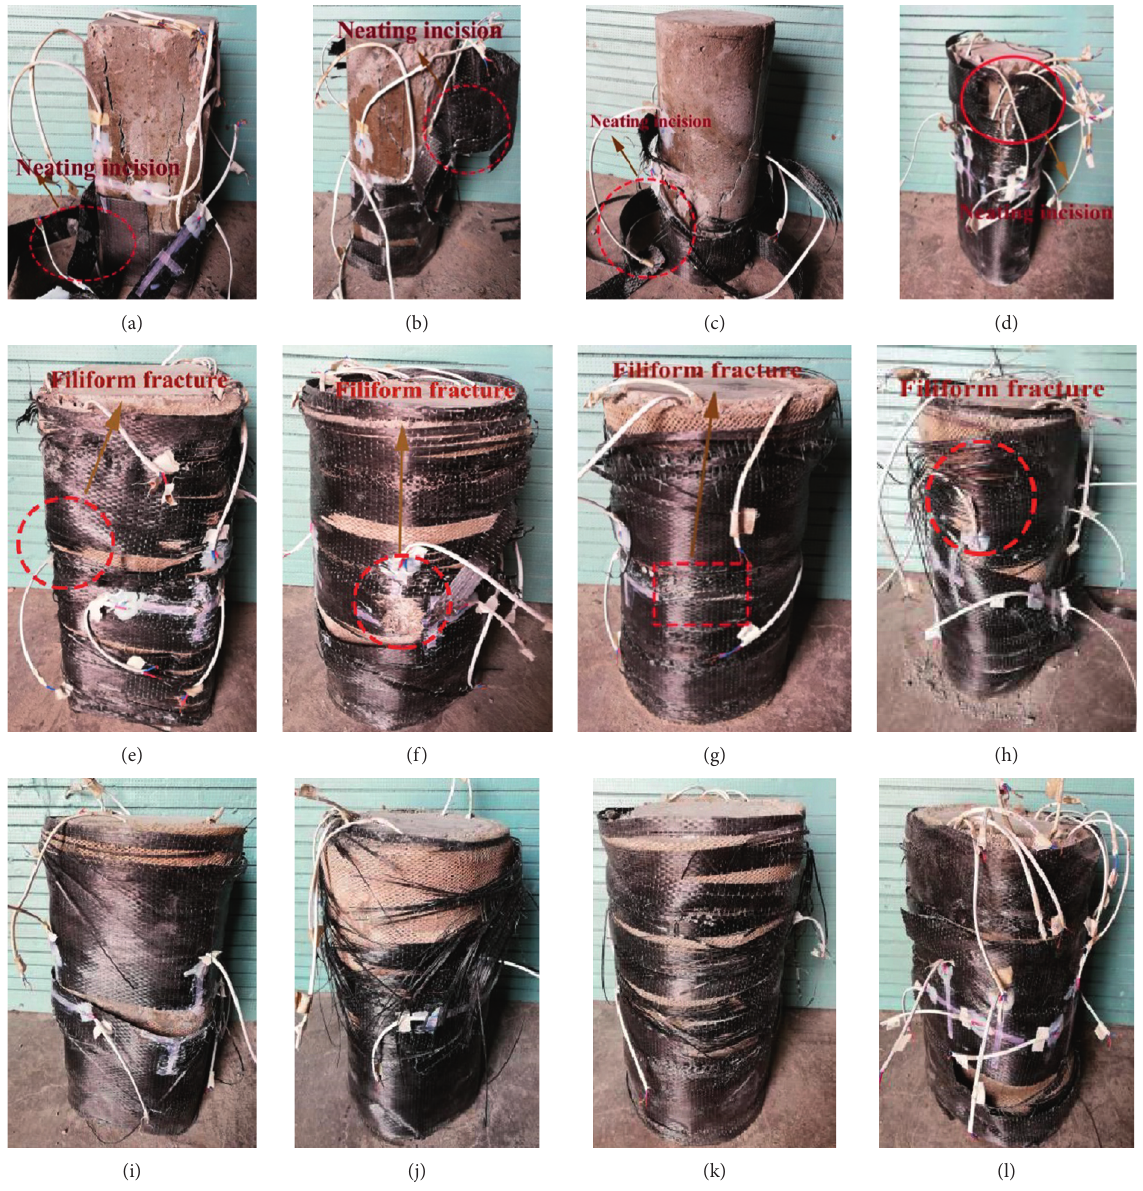
Figure 5: Failure mode of column. (a) S-0-1. (b) O-0-1. (c) C-0-1. (d) E-0-1. (e) S-1-1. (f) O-1-1. (g) C-1-1. (h) E-1-1. (i) S-2-1. (j) O-2-1. (k) C-2-1. (l)